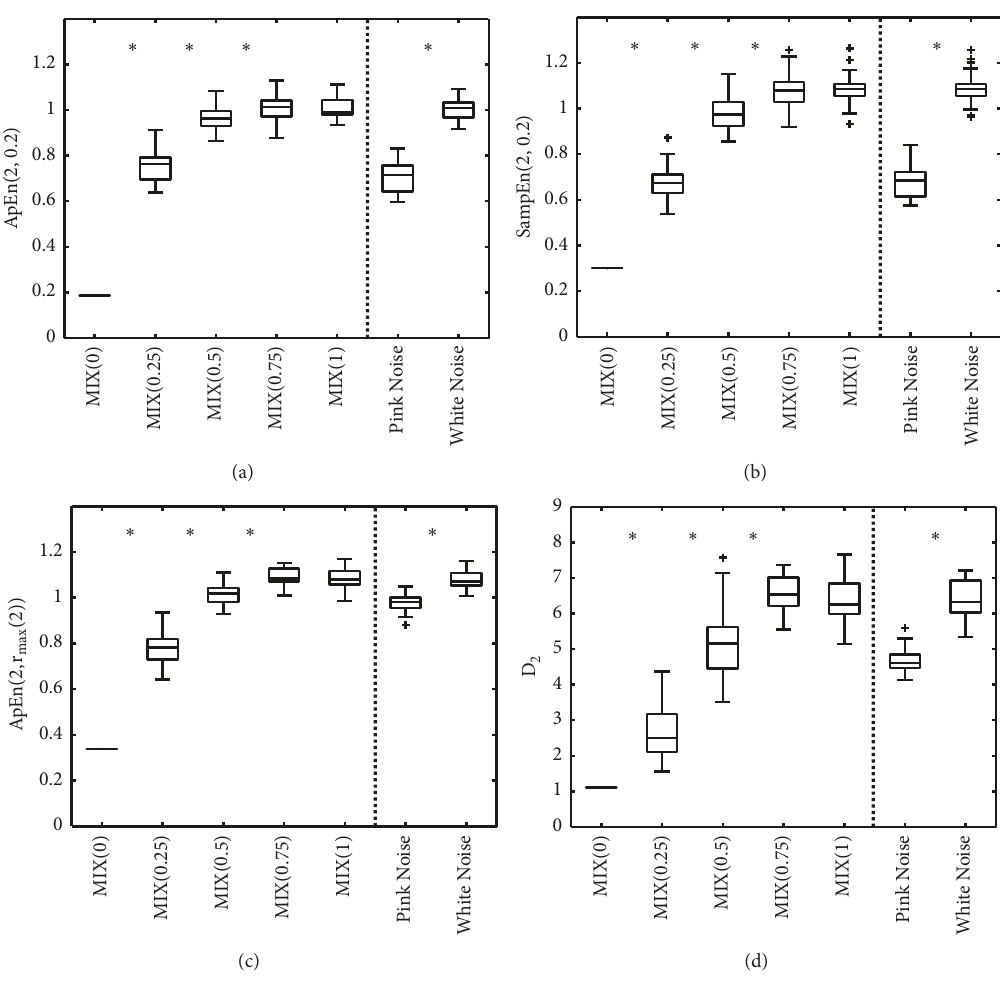
Figure 1: Nonlinear indices: (a) ApEn(2,0.2) ; (b) SampEn(2,0.2) ; (c) ApEn(2,r varying stochastic levels and pink and white noise time series. ∗ indicates statistically significant differences by Mann-Whitney U test ( p - values < 0.05) when comparing MIX( P ) processes or pink versus white noise time series. Data are shown as median and interquartile range over 30